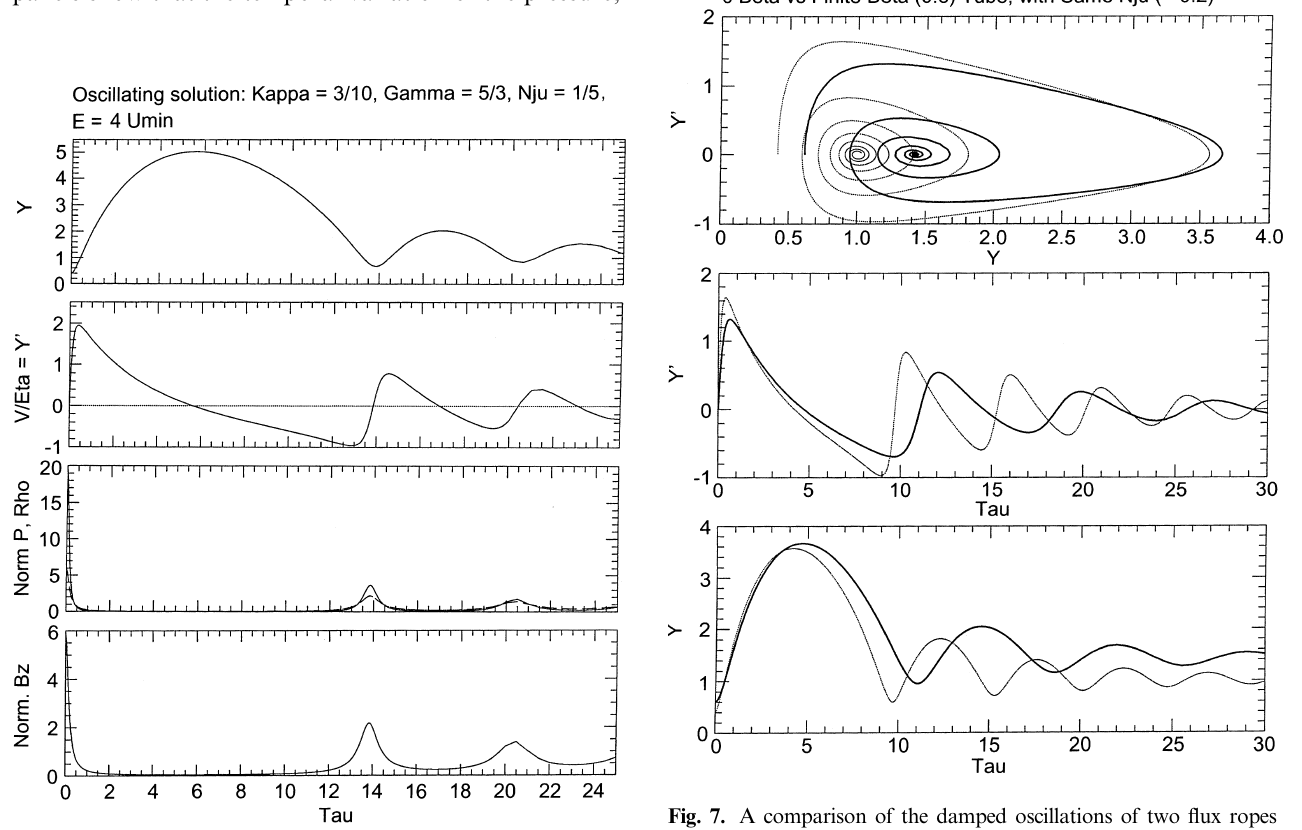
Fig. 6. Numerical solution for large-amplitude oscillations presented in the same format as Fig. 3 but with parameters as in Fig. 5